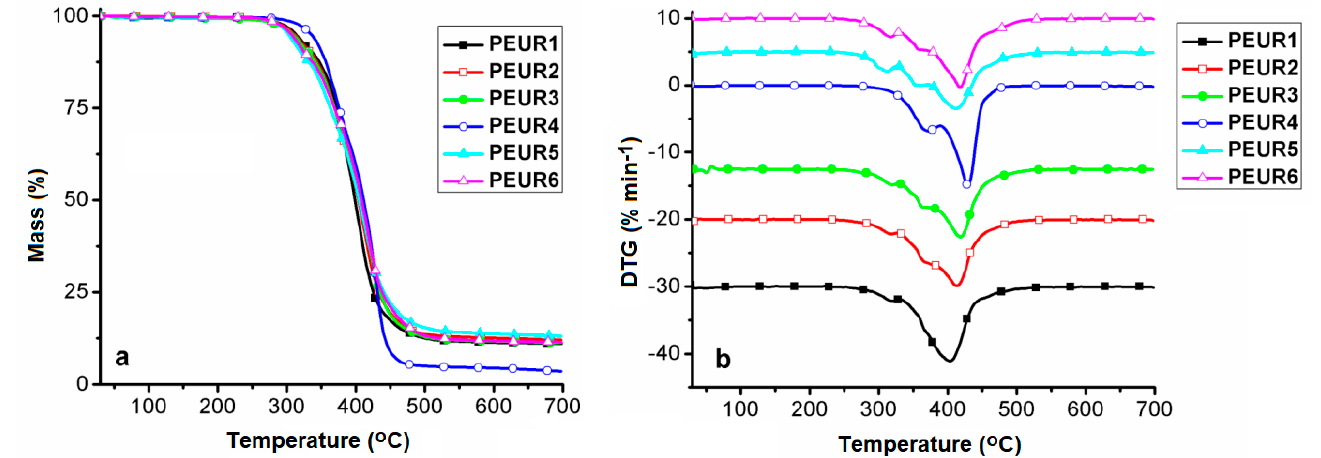
Figure 6. TG ( a ) and DTG ( b ) curves of the studied PEURs.